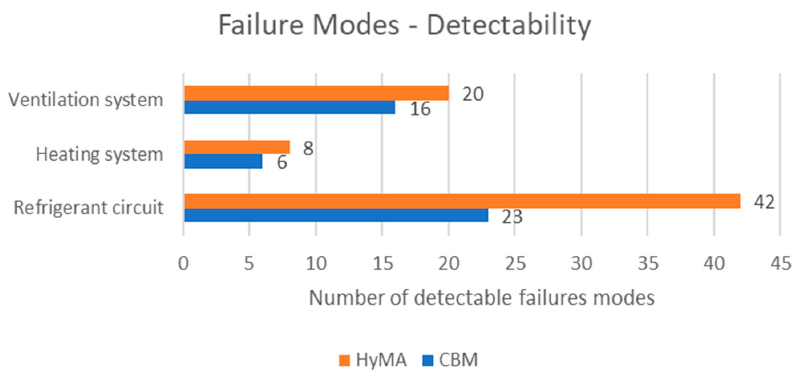
Figure 2. Detectability of FMs.